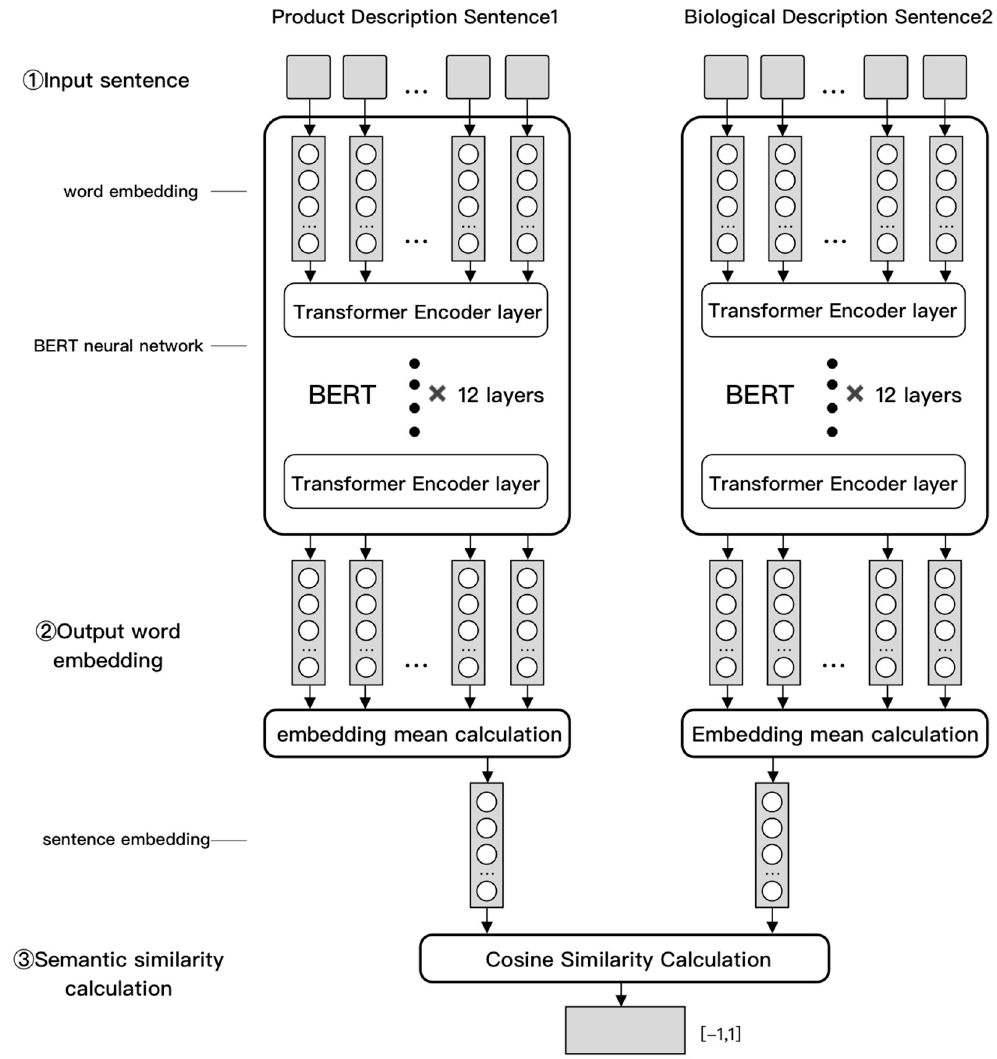
Figure 3. Product-organism semantic similarity calculation process based on the BERT pretraining model.